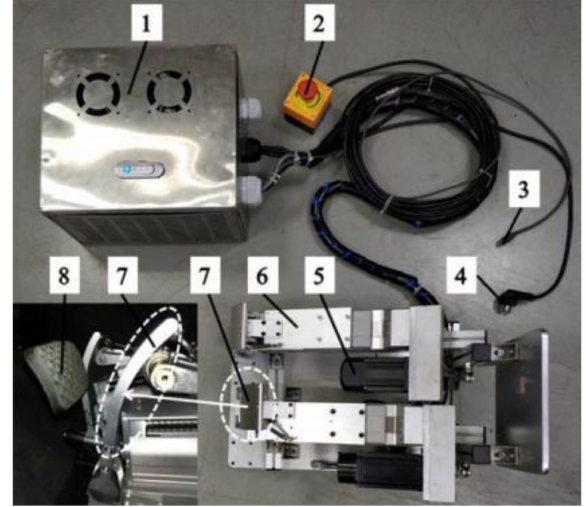
Figure 3. The robot system designed in this work. The numbers denote the following: 1—control box, 2—emergency stop button, 3—interface to the computer, 4—interface to the power supply, 5—servo motor, 6—slider, 7—end-effectors of the robot, and 8—brake pedal of the